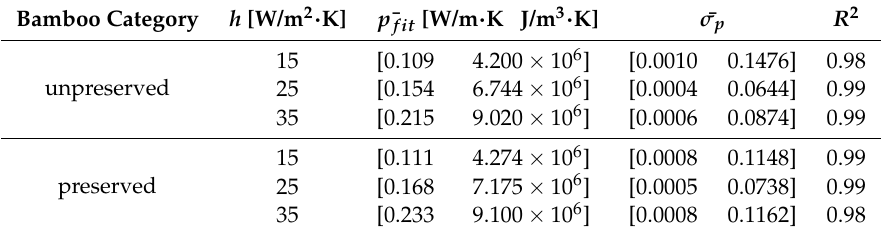
Table 2. Average parameter estimates (obtained by using the LM algorithm) for unpreserved and preserved bamboo samples. Ten bamboo samples were used to estimate ¯ p fit which is the average of the optimal estimates of each bamboo sample. The two columns in both ¯ p fit and ¯ σ p refer to k , ρ c p ,